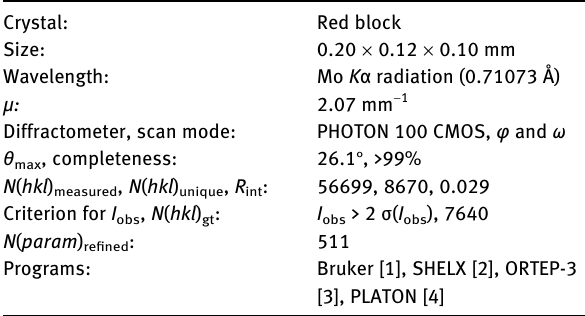
Table 1 contains crystallographic data and Table 2 contains the list of the atoms including atomic coordinates and displacement parameters.